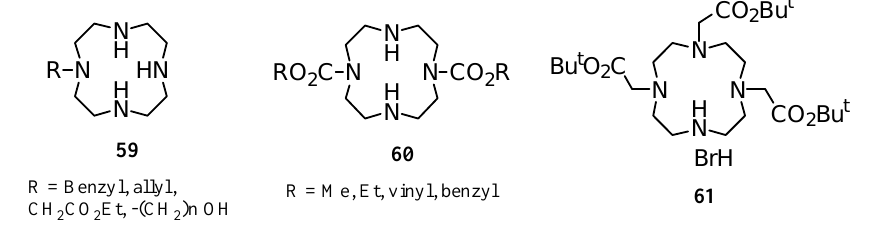
Figure 5 . Cyclen derivatives used to synthesize the most useful macrocyclic